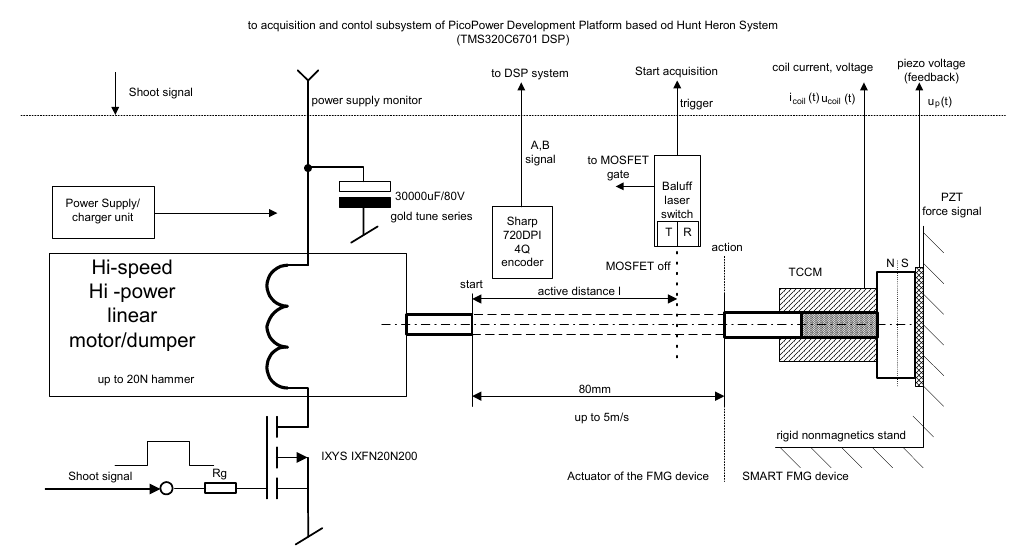
Figure 3. Test stand for TCCM harvester investigations.